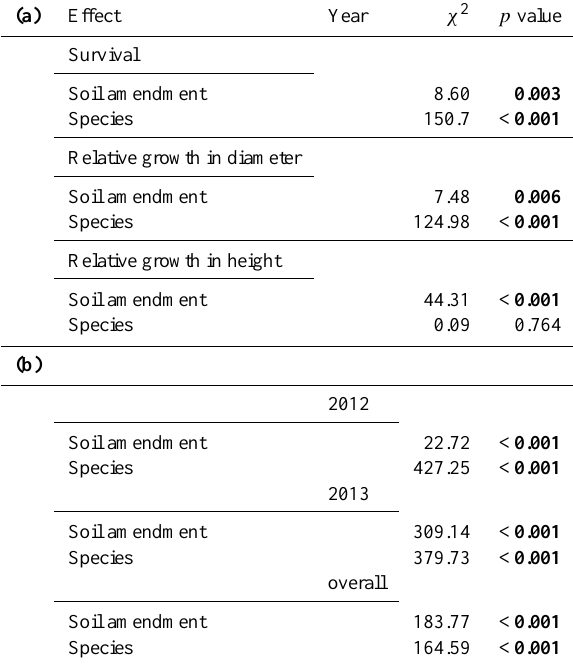
Table 2. (a ) Plant experiment: likelihood ratio tests for fixed ef- fects (soil treatment in species) based on (1) generalized mixed- effect models (GLMMs) for plant survival and (2) linear mixed- effect model (LMM) for relative growth during the first three grow- ing seasons. (b) Seed experiment: likelihood ratio tests for fixed effects (soil treatment and species) based on GLMMs for maximum seedling